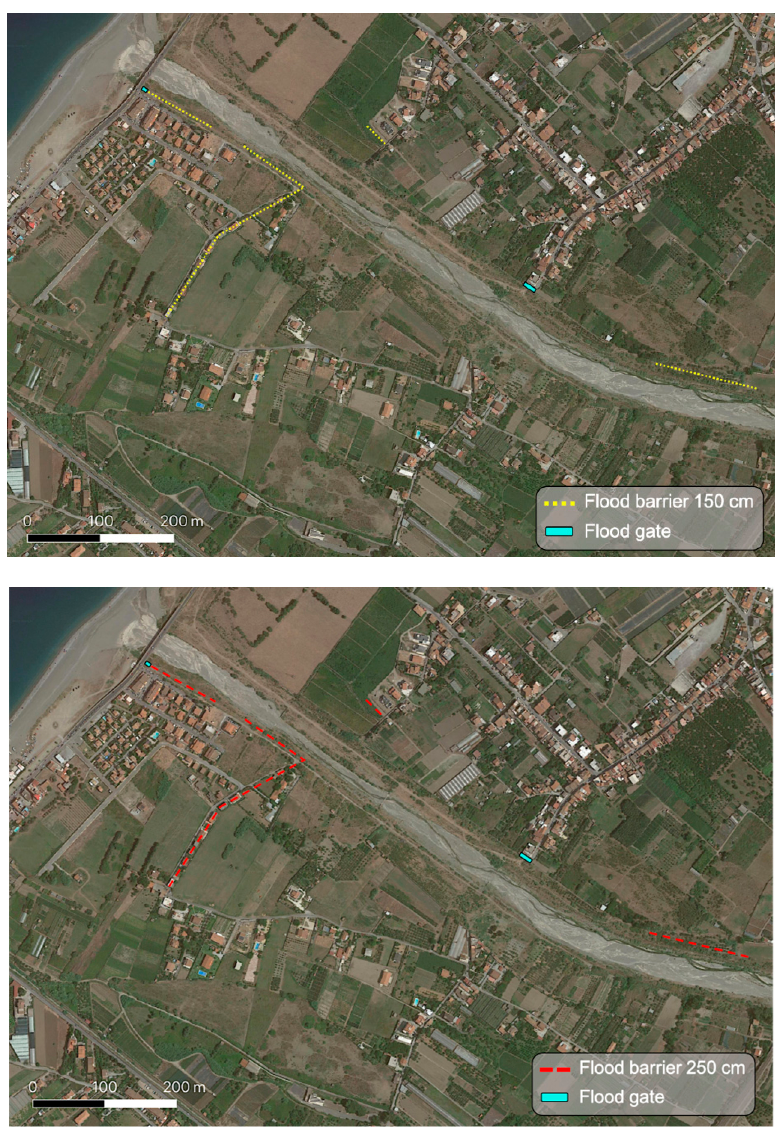
Figure 13. Locations of flood barriers: ( top ): 150 cm height; ( bottom ): 250 cm height.